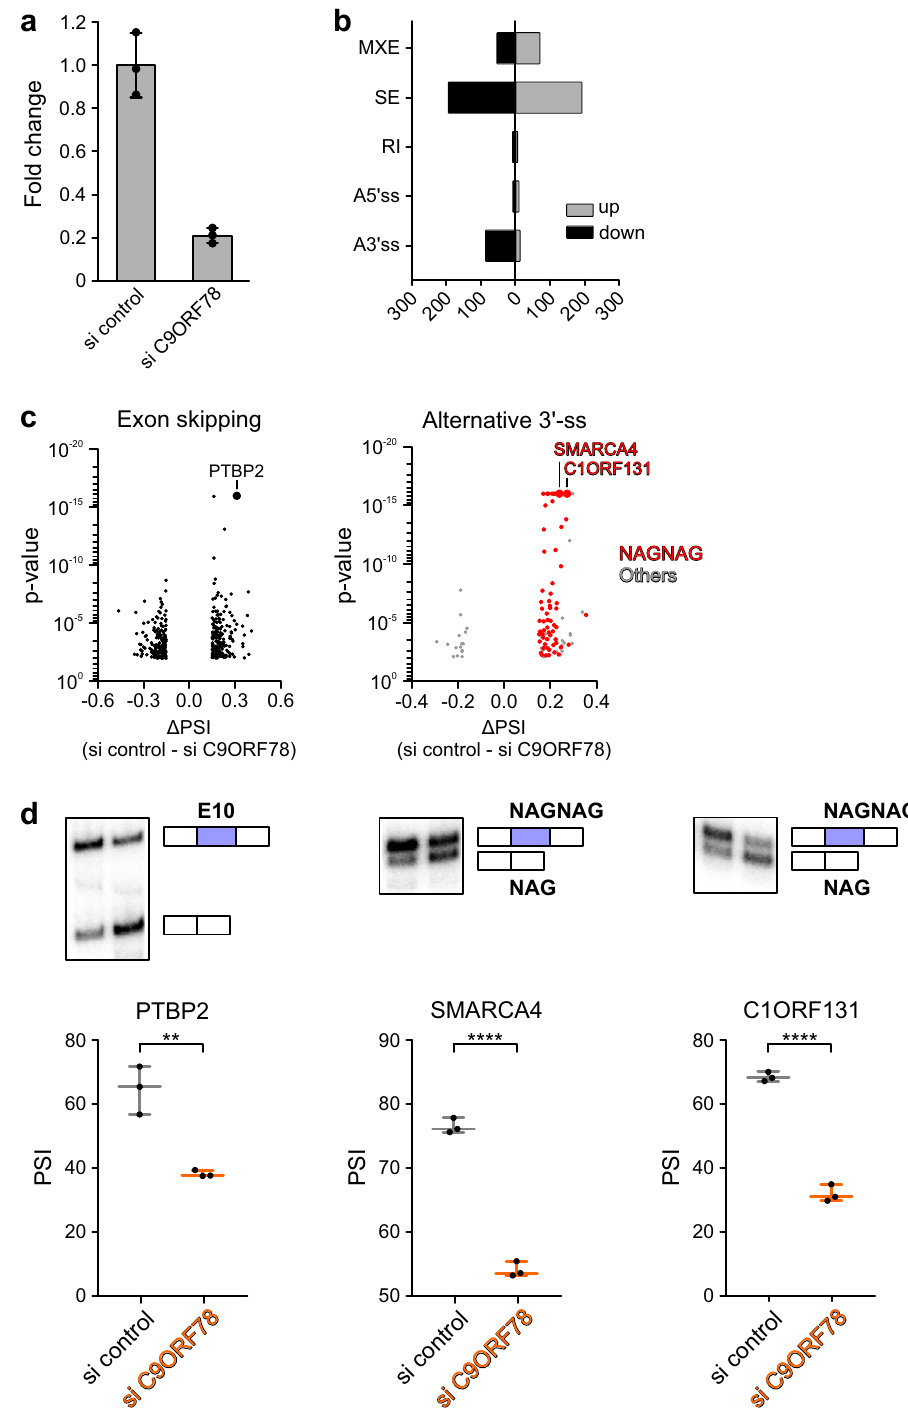
Fig. 4 C9ORF78 regulates alternative splicing. a Results from RT-qPCR analyses, showing normalized C9ORF78 expression levels relative to GAPDH expression, in cells transfected with control siRNA (si control) or C9ORF78-targeting siRNA (si C9ORF78). Bars represent means ± SD, n = 3 biologically independent experiments. b Alternative splicing changes upon siRNA-mediated C9ORF78 KD, as determined by rMATS. MXE, mutually exclusive exons; SE, skipped exon; RI, retained intron; A5 ’ /3 ’ ss, alternative 5 ′ /3 ′ -splice sites. More inclusion upon C9ORF78 KD is indicated in light gray (up), skipping in black (down). c Volcano plots of signi fi cantly changed skipped exons (left; n = 390), and alternative 3 ′ -splice sites (right, n = 105; red, NAGNAG splice sites, n = 59) upon C9ORF78 KD. Targets selected for validation PCR (PTBP2, C9ORF131, SMARCA4) are indicated by large data points and labeled. d Validation PCRs con fi rm C9ORF78 KD-induced changes in alternative splicing. Top, representative gels. Bottom, quanti fi cations ( n = 3 biologically independent experiments). Horizontal lines, medians; whiskers, minimum/maximum values. PSI, percent spliced-in (gel analysis), ratio of the quanti fi ed band representing exon inclusion and the sum of the quanti fi ed bands representing exon inclusion and exon skipping. Statistical signi fi cance was determined by unpaired, two-sided t-tests; ** p = 0.0038; **** p < 0.0001. Source data for a – d are provided as a Source Data fi